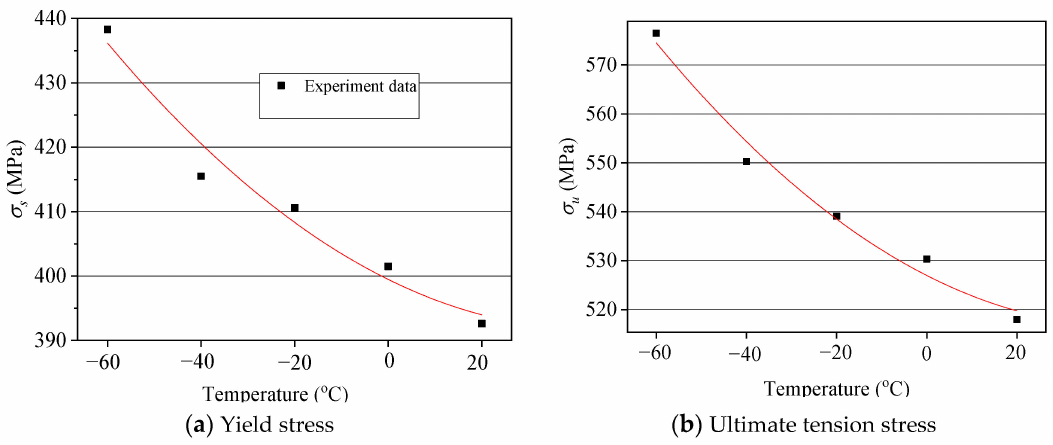
Figure 6. Yield stress and ultimate tension stress at different temperatures (average). Except for the yielding and ultimate tensile stress, low temperatures affects the engi- neering fracture strain significantly, as shown in Figure 7. The low temperatures induce a decrease in the engineering fracture strain, as well as the strain rate. Under the same temperature, the engineering fracture strain decreases with the increase in the strain rate.